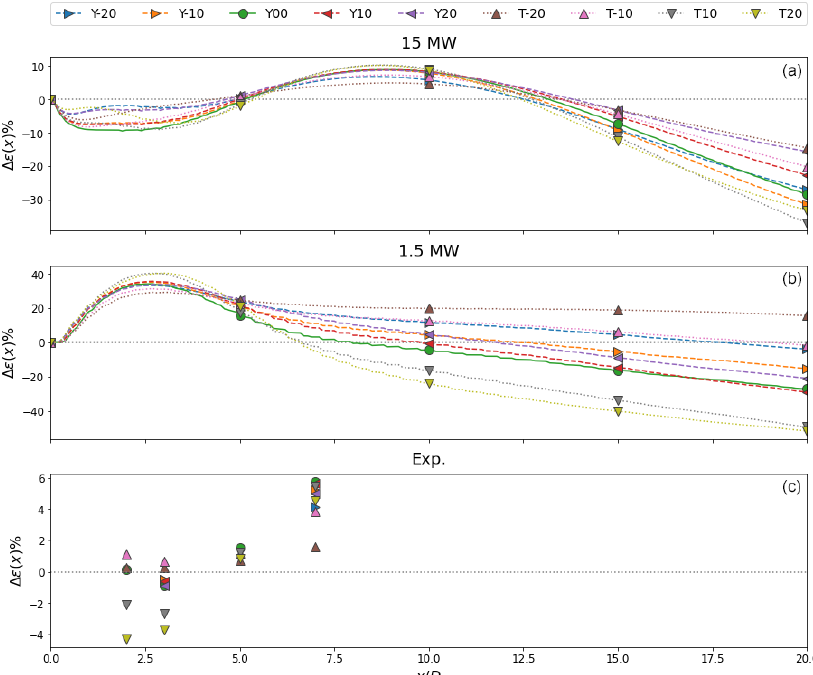
Figure 12. Relative error between eddy viscosity formulations for the 15MW (a) , 1.5MW (b) , and scaled model turbine (c) cases. Positive values indicate regions where the proposed model reduces flow field error relative to the proposed formulation while negative values show areas where the proposed model introduces additional